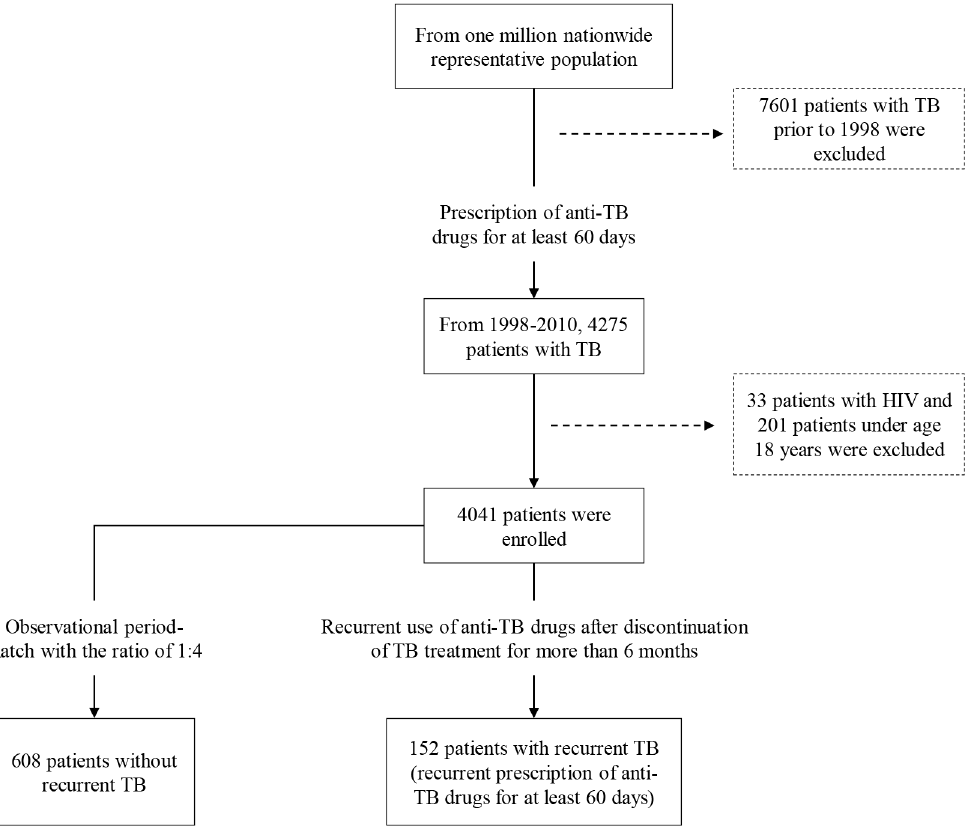
Fig 1. Flow diagram for the enrollment of study participants in the nested case-control study. After excluding patients with antecedent TB prior to 1998, HIV infection and those less than 18 years of age, the numbers of nested cohort, case and control were 4041, 152 and 608,